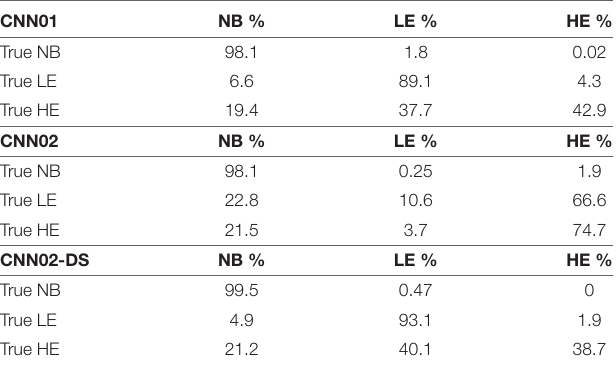
TABLE 4 | Classification accuracy comparison for CNN01 , CNN02 , and CNN02-DS , using post-training quantization (PTQ). CNN01